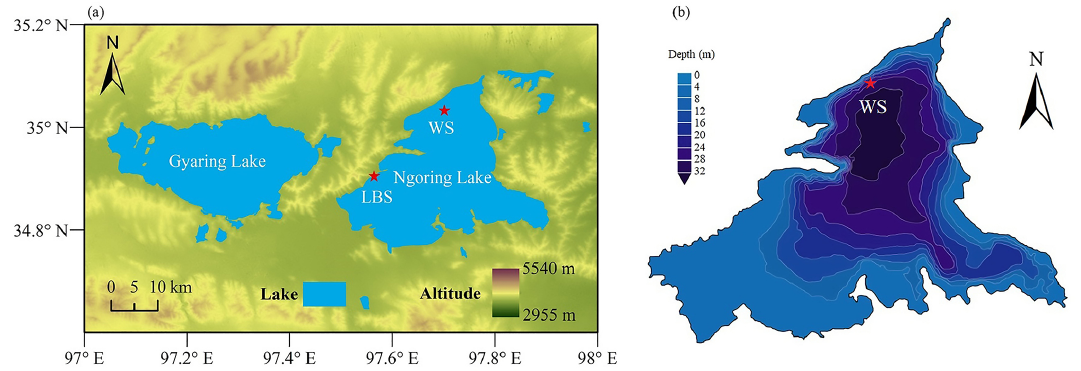
Figure 1. (a) Location and (b) bathymetry of Ngoring Lake. Panel (b) is adapted from Kirillin et al. (2021a). The pentagrams denote the lake border station (LBS) and water temperature measurement site